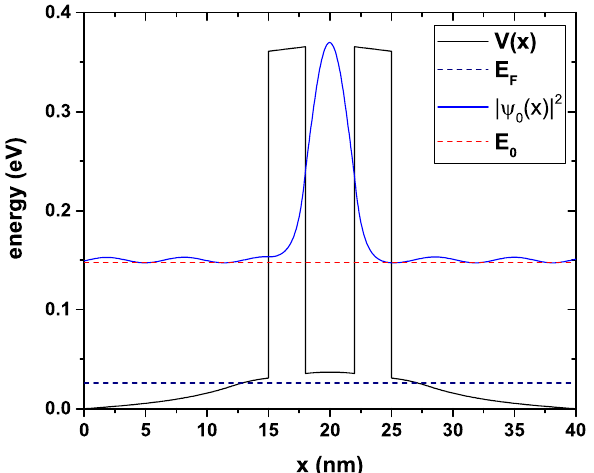
Figure 3. Potential energy for the system in equilibrium (bias voltage 0.0 V), the blue curve corre- sponds to the probability density of the resonant state, and the red dashed curve is the energy for this state E 0 . The quasi-Fermi level is also presented with the blue dashed curve. The calculations are for L w = 4nm, L b = 3nm, L s = 3nm, L d = 12nm and n d = 1.2 × 10 18 cm − 3